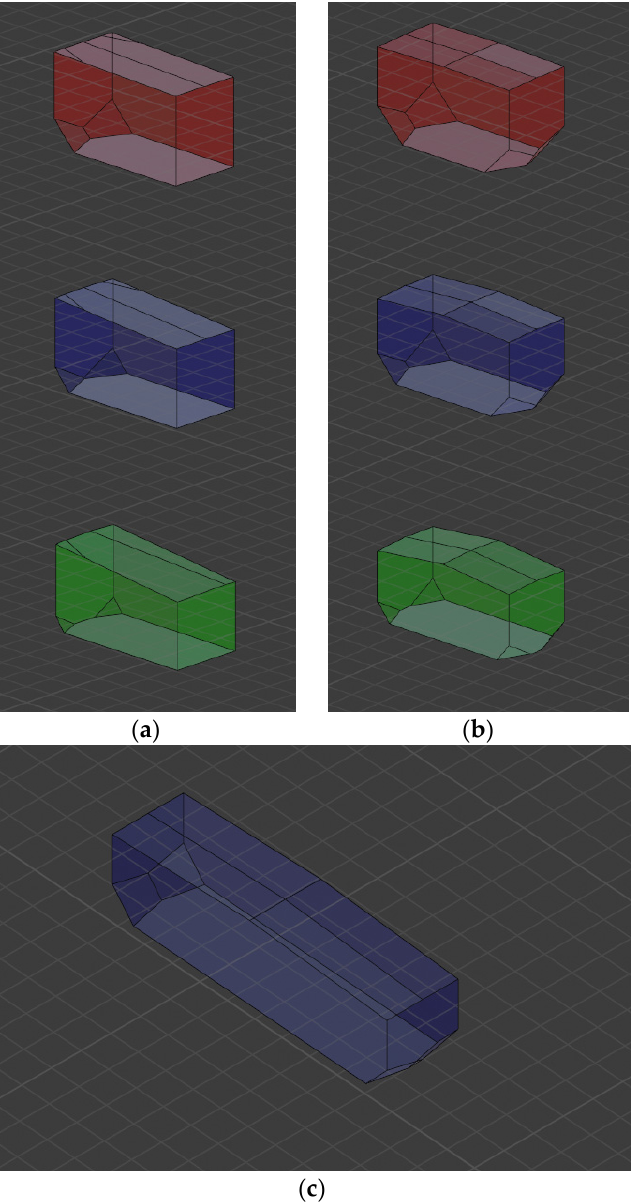
Figure A3. Capture-volume meshes: ( a ) four-camera corner, ( b ) four-camera arc, ( c ) eight-camera perimeter.